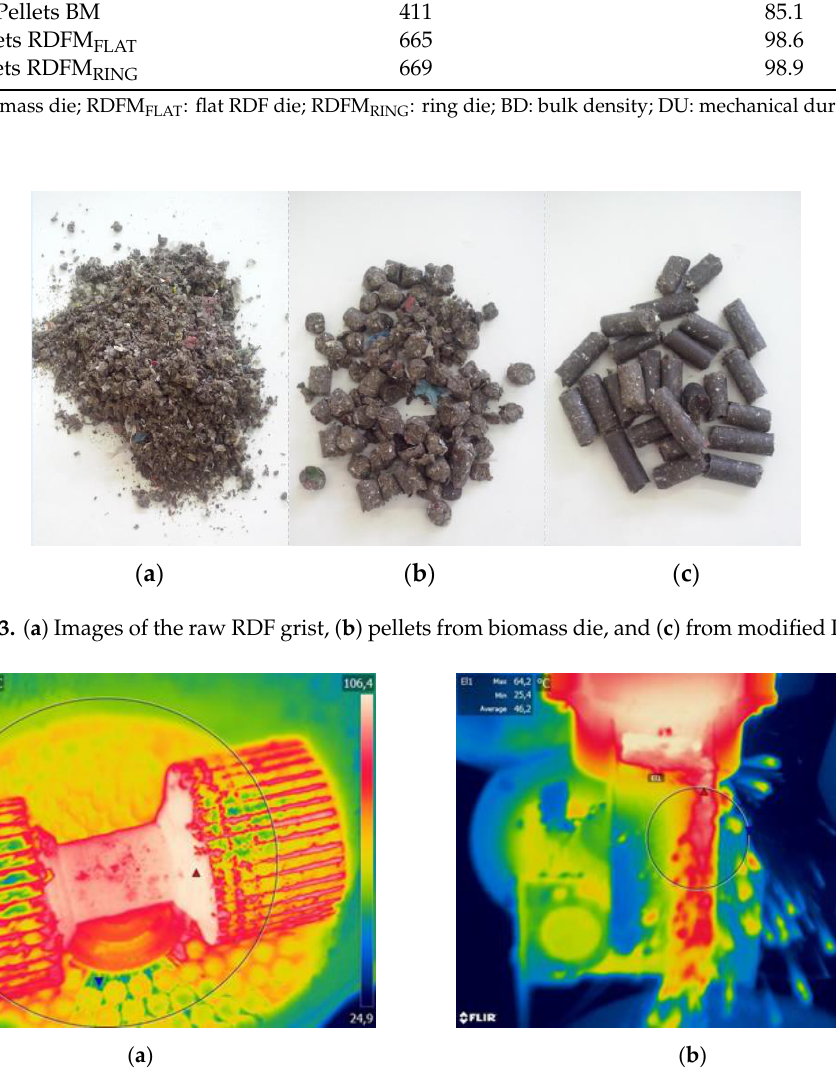
( b ) Figure 15. ( a ) Modified die (blue) compared to standard biomass die (green), and ( b ) modified die mounted into the pelletiser. 3.4. Flat Die and Semi-Professional Line Results The standard, used for biomass densification and redesigned for the RDF dies, was compared. From this test, we acquired information about bulk density and mechanical durability of the pellets. The results are presented in Table 1. Table 2. Pellet quality and raw materials. ID